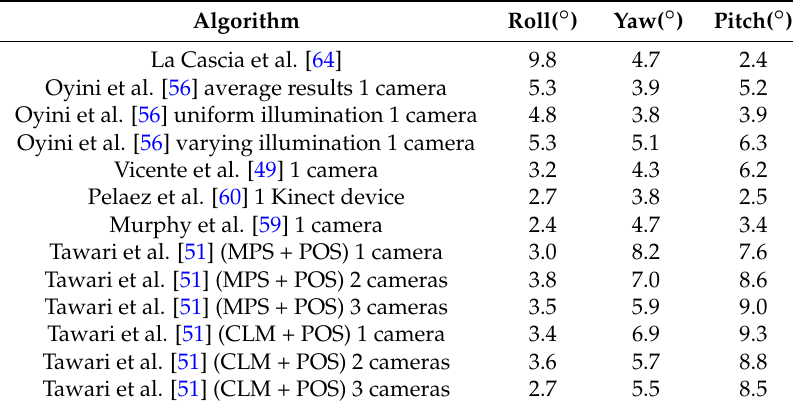
Table 1. Mean Absolute Error (MAE) (in degrees) of face tracking algorithms comparison working in an automobile